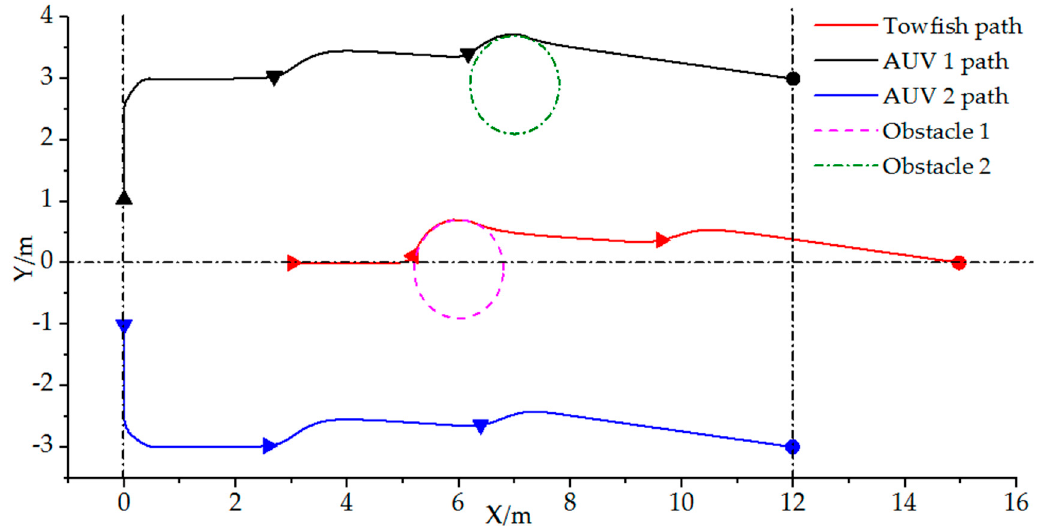
Figure 12. Vehicle formation paths with obstacle avoidance.